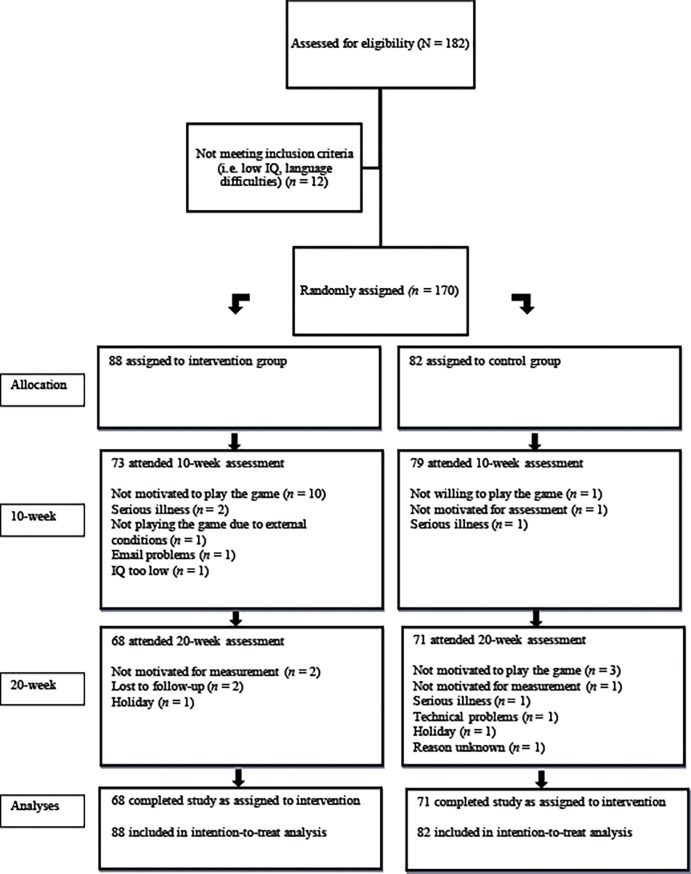
Study flow diagram.